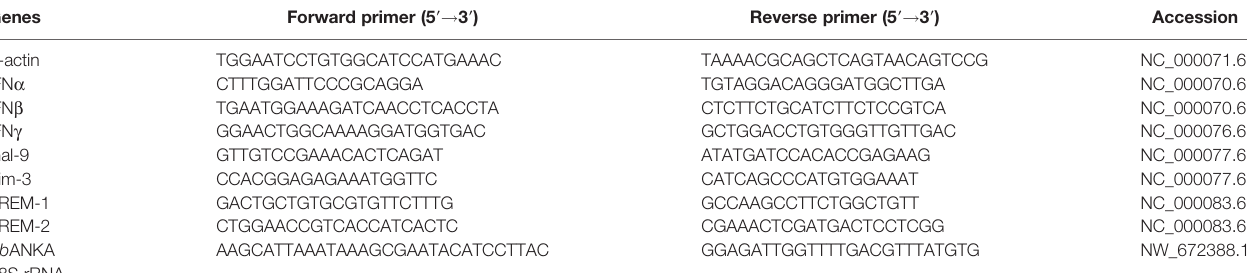
TABLE 1 | Primer sequences of genes used for quantitative real-time reverse transcription-polymerase chain reaction assay.